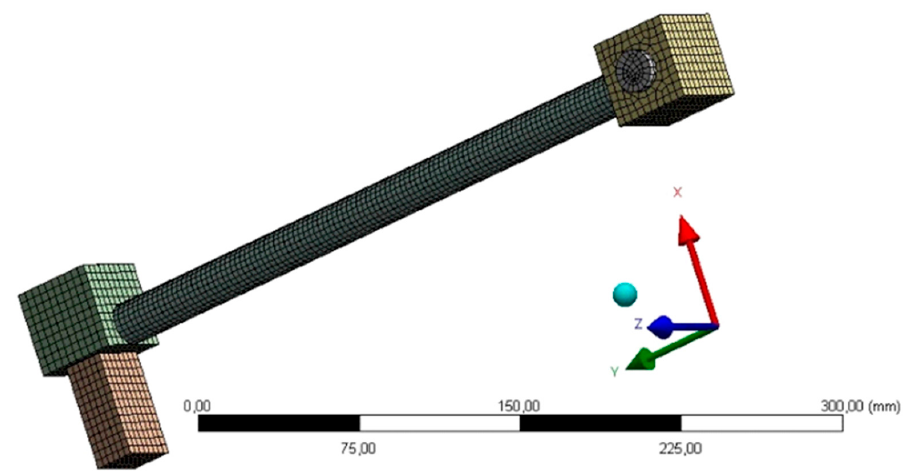
Figure 10 . Numerical model of the pendulum Ф = 20 mm .